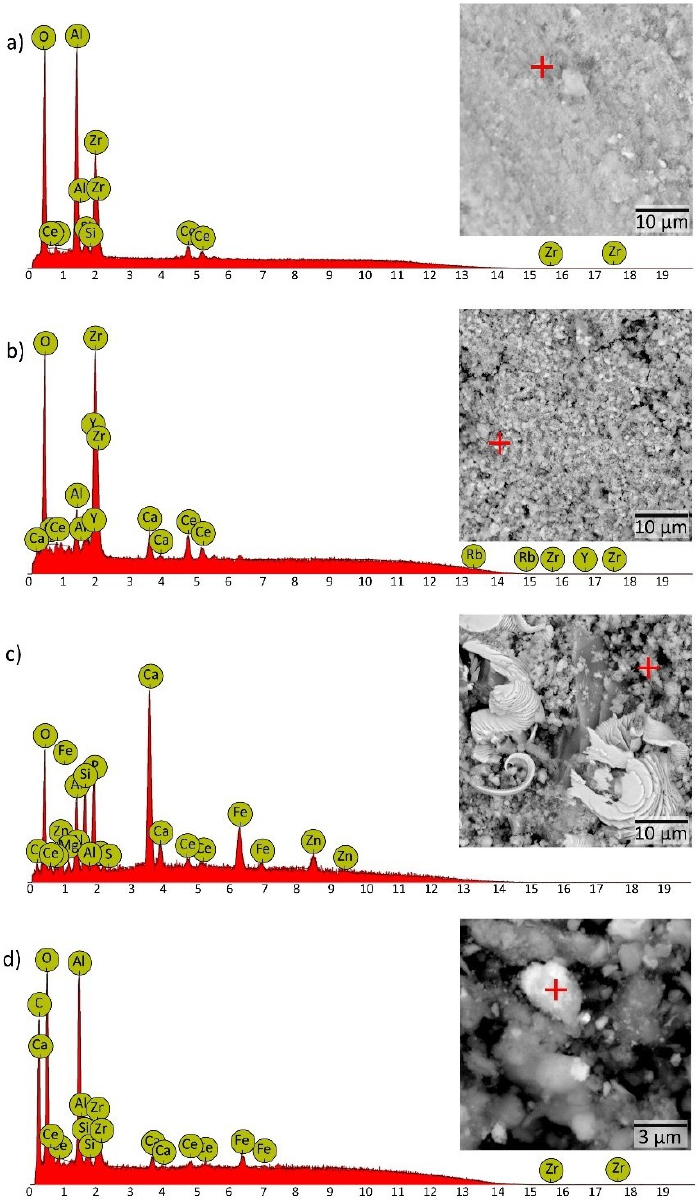
Figure 7. SEM image and EDS analysis for element identification from ( a ) brand-new TWC, ( b ) moderately used TWC, ( c ) highly used TWC and ( d ) pipe exhaust sample.